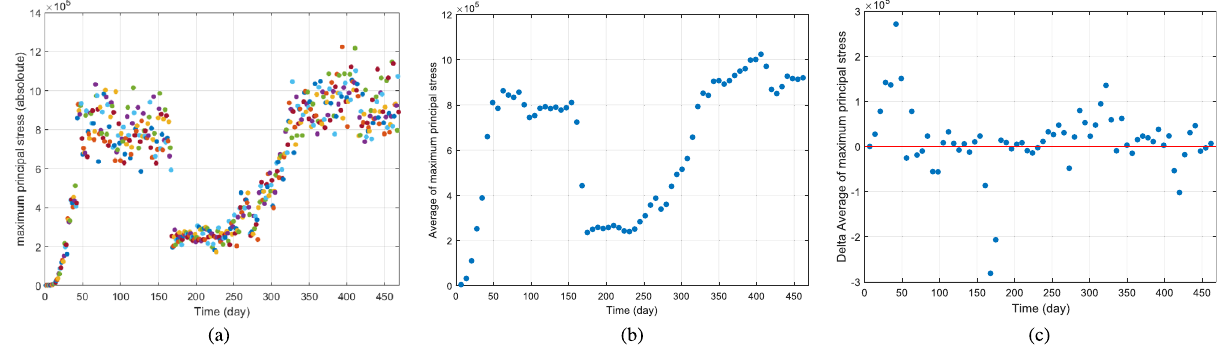
Figure 5. Establishing the growth rate criteria: ( a ) Daily time-series related to cluster j ∈ C and m = | C | = 2 of maximum values of principal stresses of σ 1, s , j , σ 2, s , j , and σ 3, s , j for every active node. ( b ) Filtered signal with an overlapping window with a length of 2 weeks ( 1 week overlap). ( c ) The point-to-point difference in the values of the signal in ( bb ) is defined as the metric for pandemic growth.